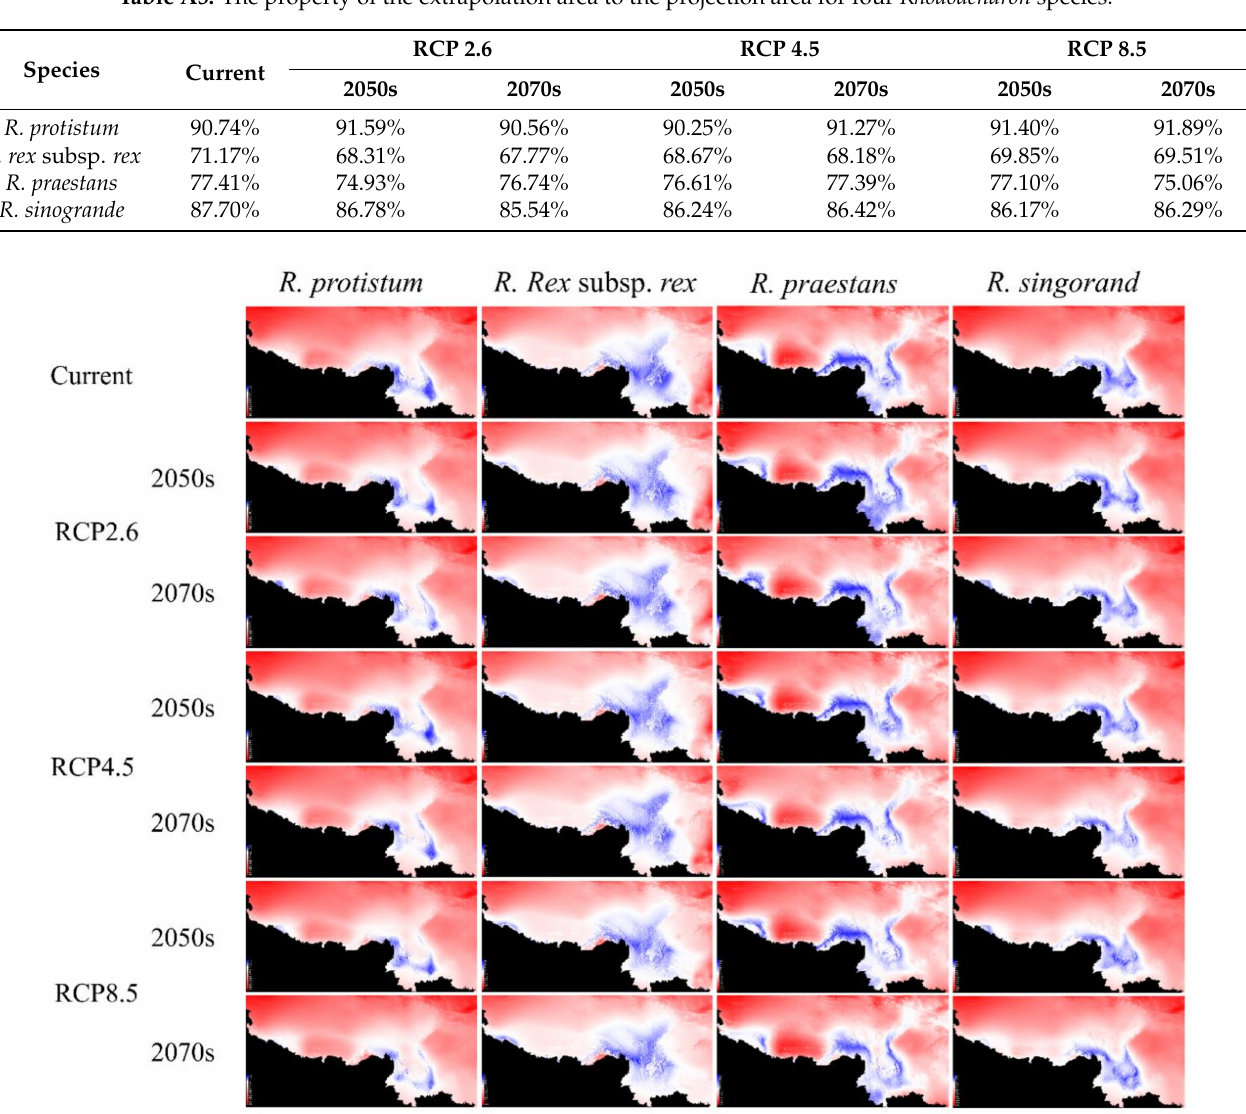
Table A5. The property of the extrapolation area to the projection area for four Rhododendron species.